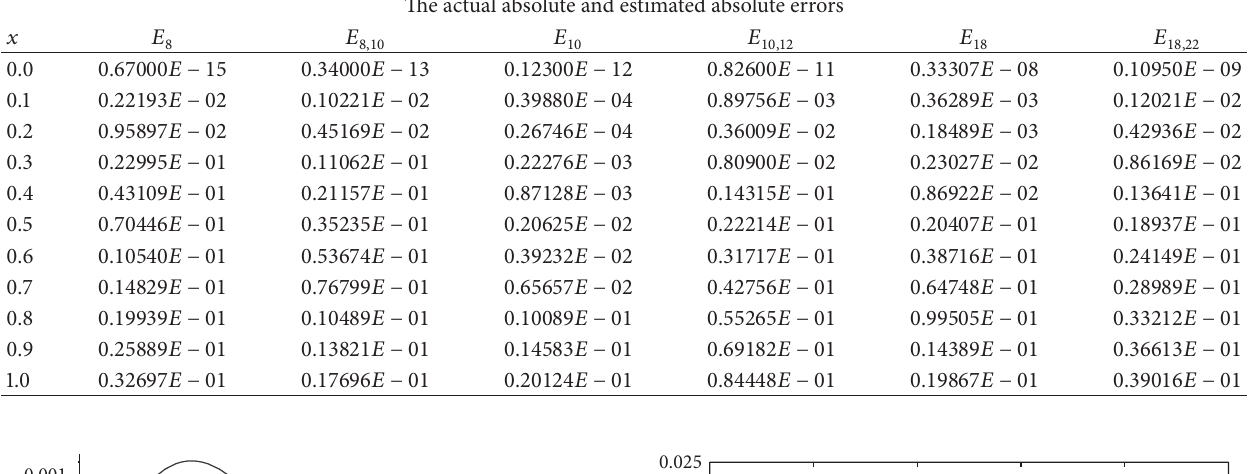
Table 4: Comparison of the actual and estimated absolute errors for 𝑁 = 8,10, 18 and 𝑀 = 10, 12, 22 of Example 5. The actual absolute and estimated absolute errors